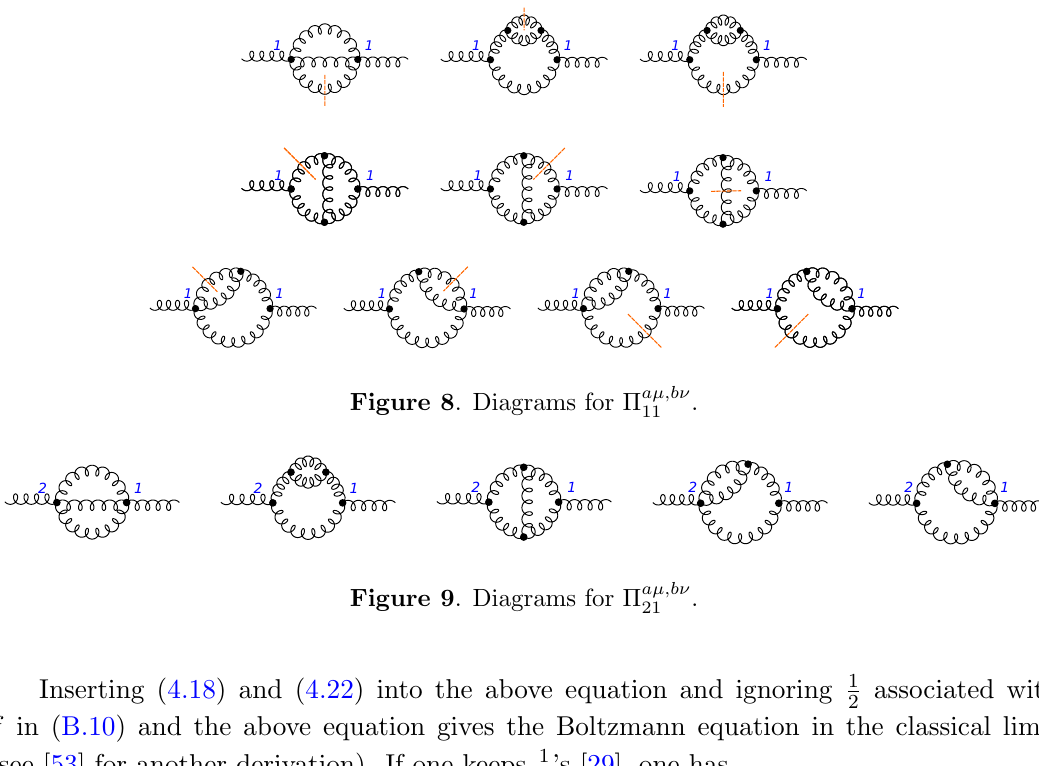
Figure 9 . Diagrams for (cid:5) a(cid:22);b(cid:23)